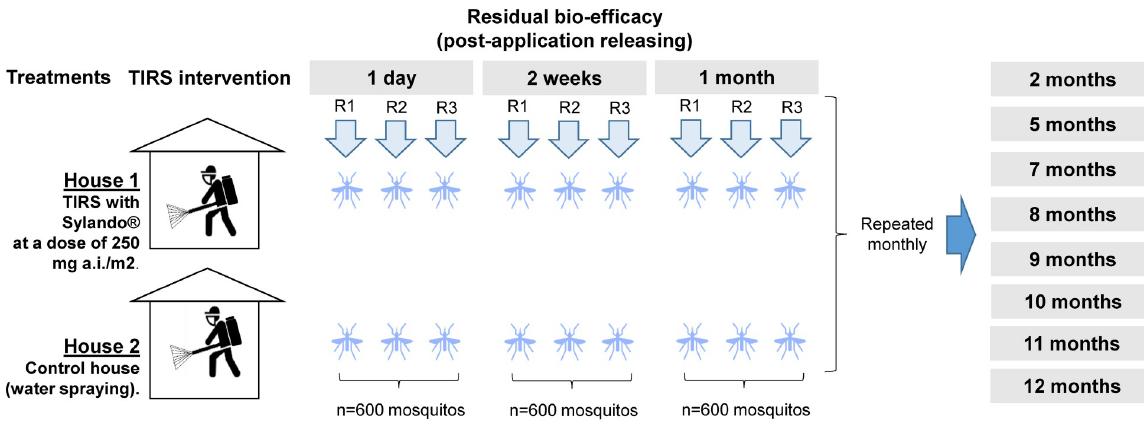
Fig 2. Study design. Each arrow represents a releasing event. R =